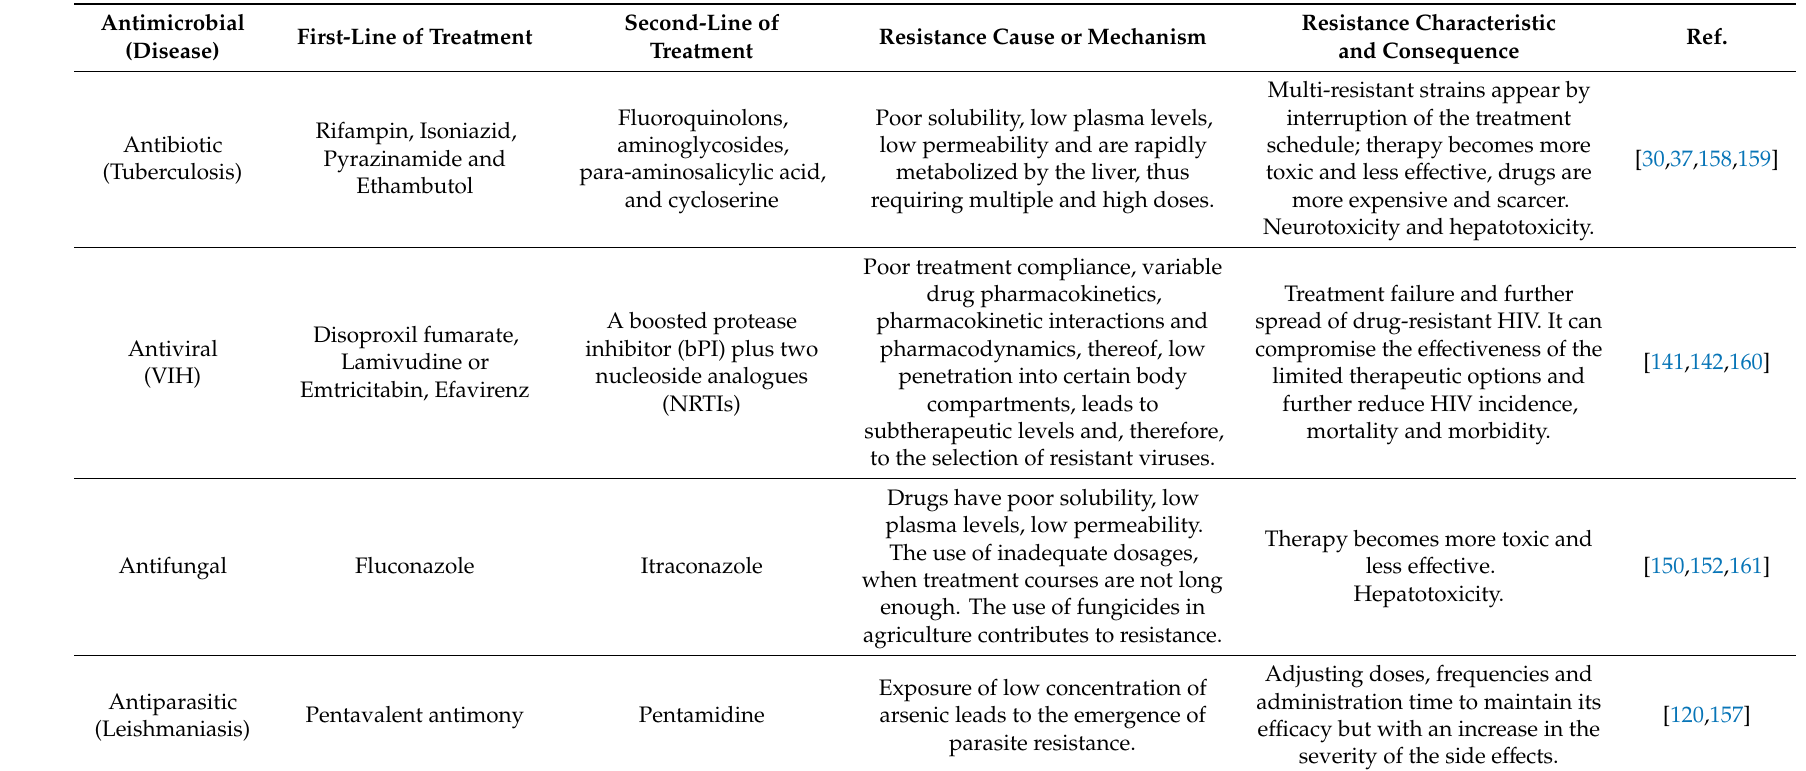
Table 2. Some examples of antimicrobials